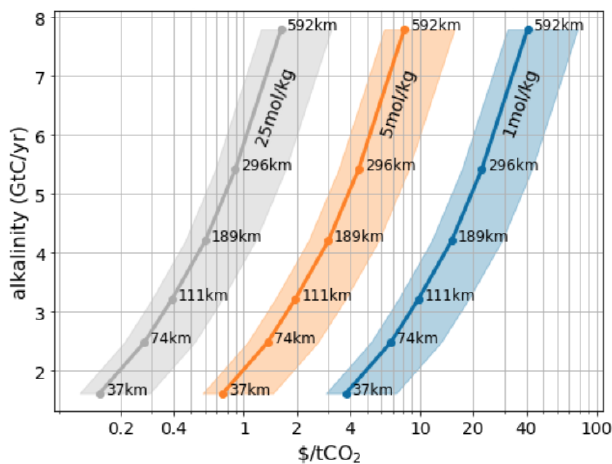
Figure 8. Total carbon uptake potential for a variable alkalinity addition strategy that results in a maximal pH change of 0.1 (see Fig. 1 for an example). Carbon uptake is estimated at η CO The strip widths necessary are indicated for each point. Shading de- notes the shipping cost uncertainty, which ranges from USD0.0016 to 0.004 per tonne per kilometer (Renforth,